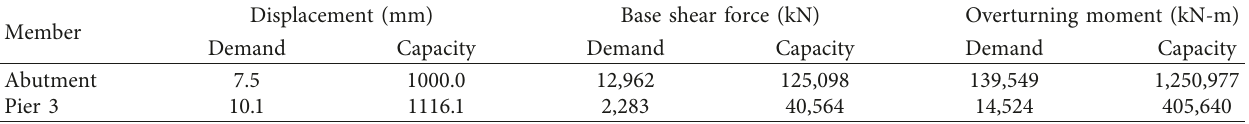
Table 3: Comparison of demand and capacity results.